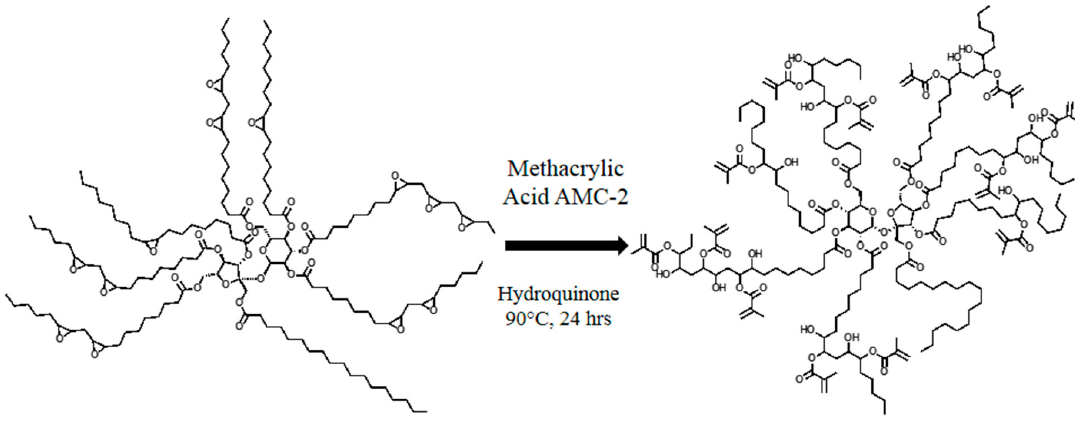
Figure 2. Synthetic route to MESS.